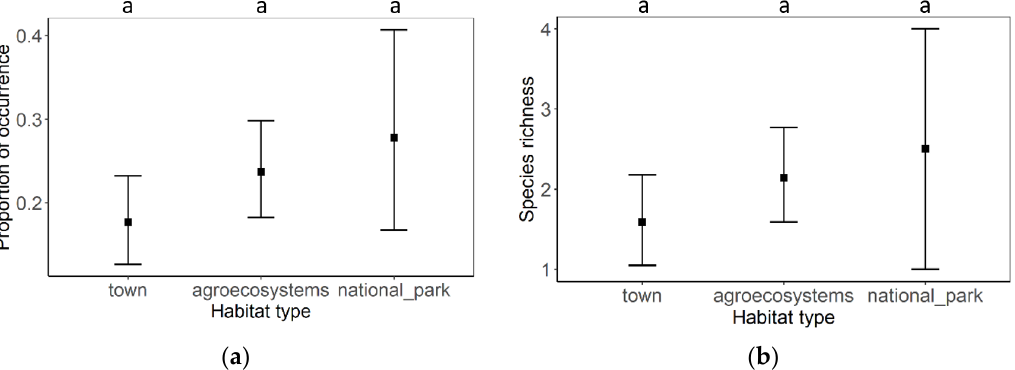
Figure 4. ( a ) The proportion of viral pathogens occurrence in different types of habitats and ( b ) comparison of species richness of viral pathogens between different types of habitats. Black squares represent means and the error bars represent 95% confidence intervals. Significant differences (<0.05) are indicated by different letters.